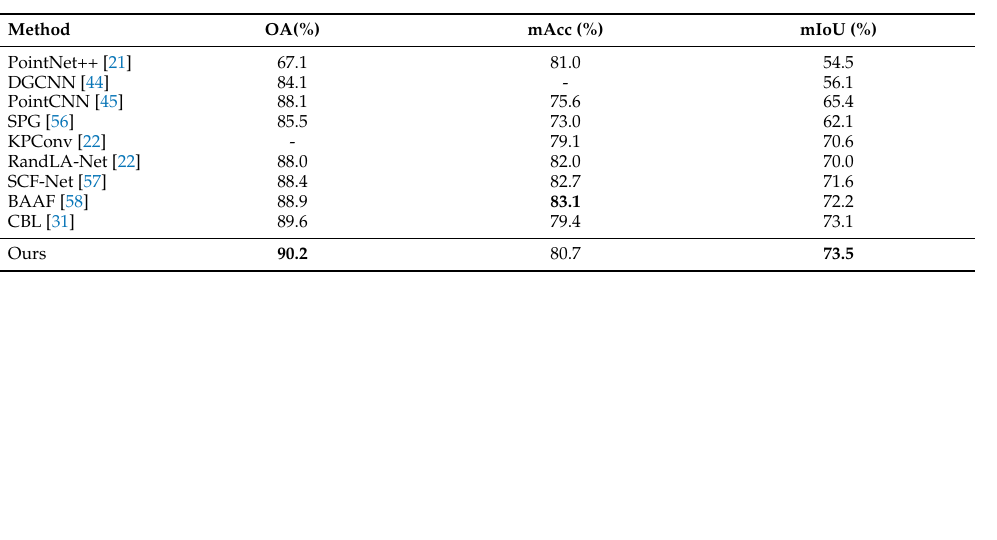
Table 4. Quantitative comparison of different methods on the S3DIS dataset (6-fold cross-validation). The bold denotes the best